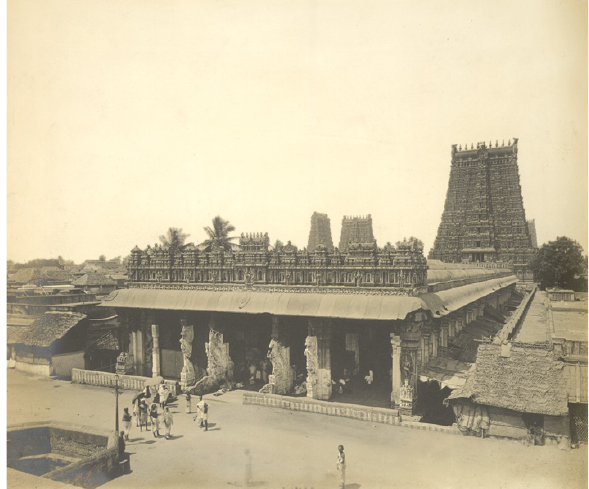
Figure 5. General view of Pudumandapam from the north-east, near Minakshi Amman Temple, Madura. ASI 1899-1900